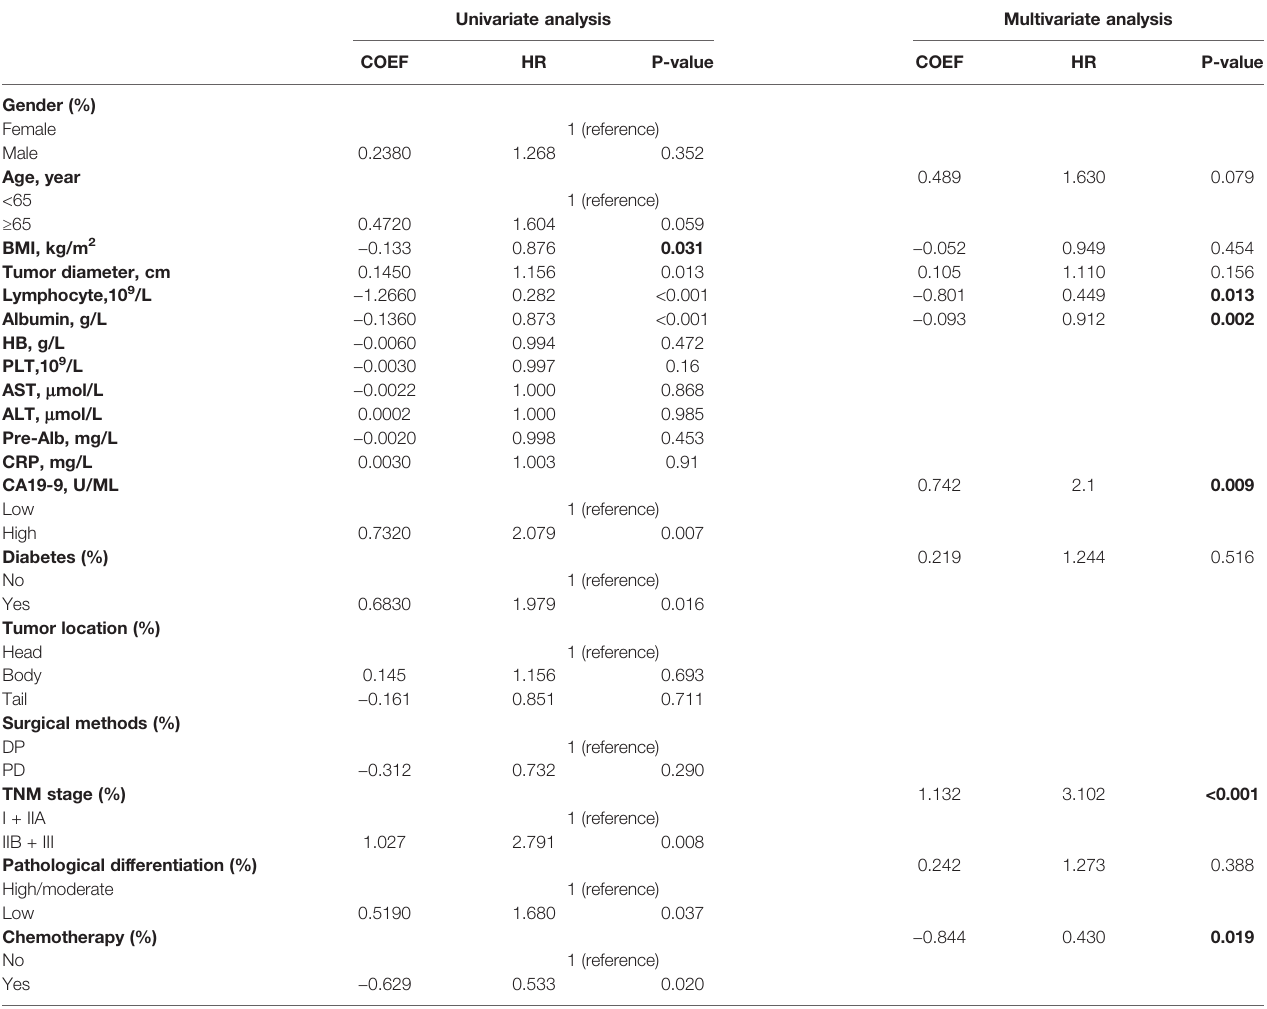
TABLE 2 | Univariate and multivariate analyses of predictive factors for 2-year overall survival in the training group (n = 95). Univariate analysis Multivariate analysis COEF